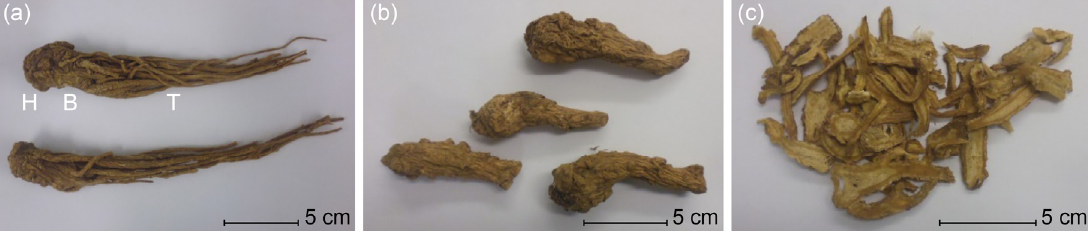
Figure 1. ( a ) Whole root of Angelica sinensis (Quangui) with head (H), body (B), and tail (T); ( b ) The combined head and body are nowadays commonly sold as head (Guitou); ( c ) Sliced dang gui (Guipian).